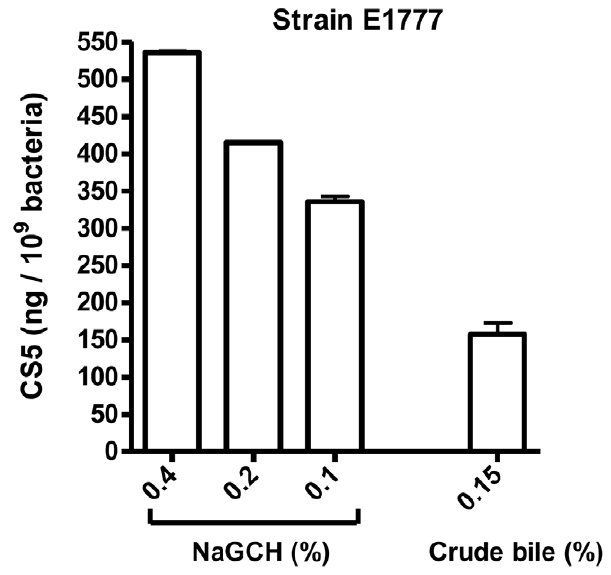
Figure 5. Dose-dependent induction of phenotypic CS5 expression by NaGCH. Expression of CS5 was determined by inhibition ELISA in strain E1777 after overnight culture to stationary phase in LB medium supplemented with NaGCH or crude bile. Bars indicate means and standard errors of the means of two measurements in one